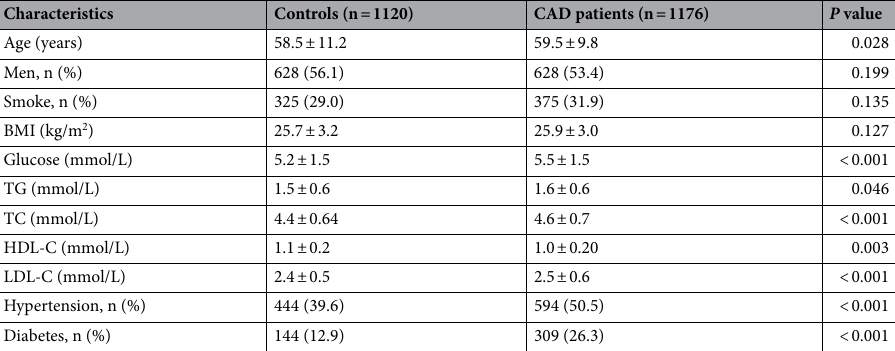
Table 1. Clinical characteristics of including control participants and CAD patients. Continuous variables are expressed as mean ± SD. Categorical variables are expressed as percentages. CAD coronary artery disease, BMI body mass index, TG triglyceride, TC total cholesterol, LDL-C Low density lipoprotein-cholesterol, HDL-C high-density